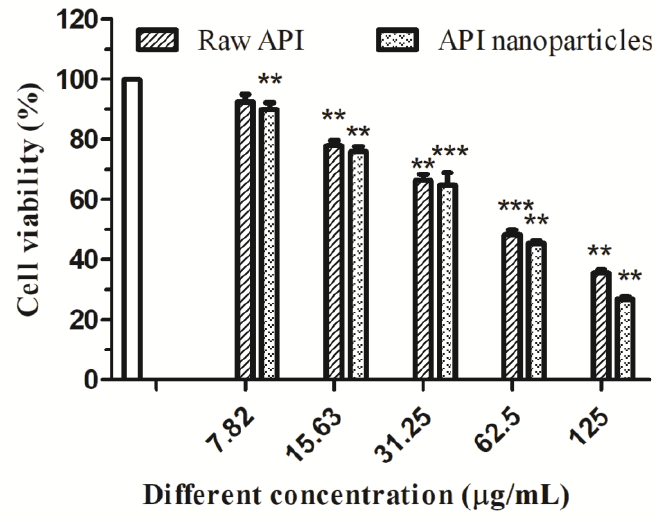
Figure 14. Effects of raw API and API nanoparticles on HepG2 cells’ viability (** p < 0.05; *** p < 0.01).